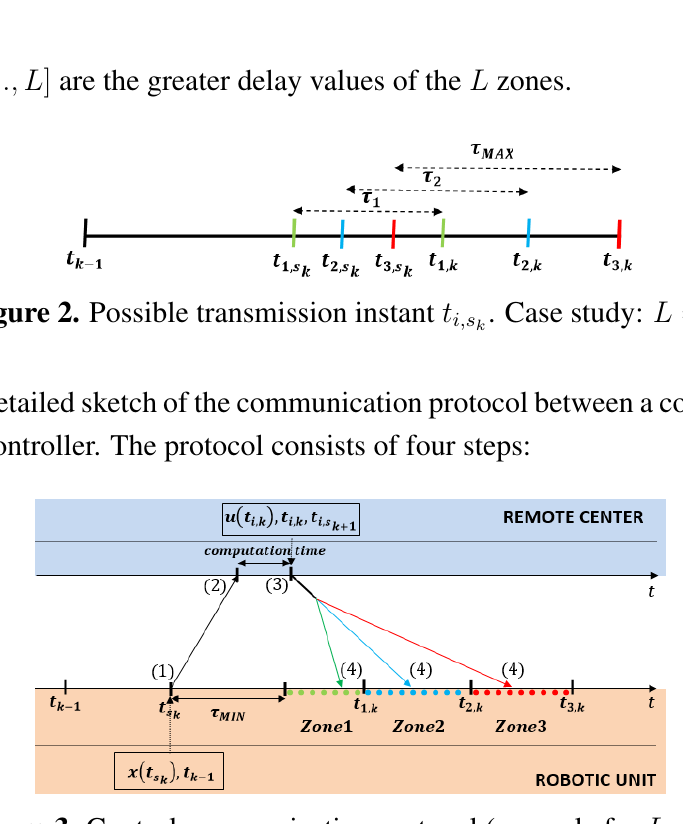
Figure 3. Control communication protocol (example for L = 3